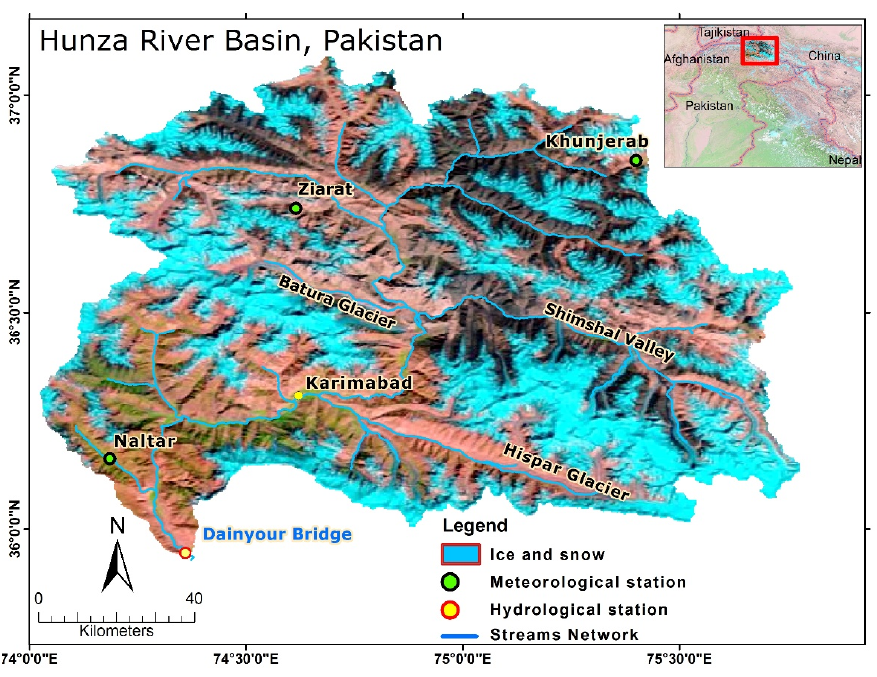
Figure 1. Study area in northern Pakistan, representing the streams, valleys, and locations of the meteorological and hydrological stations.